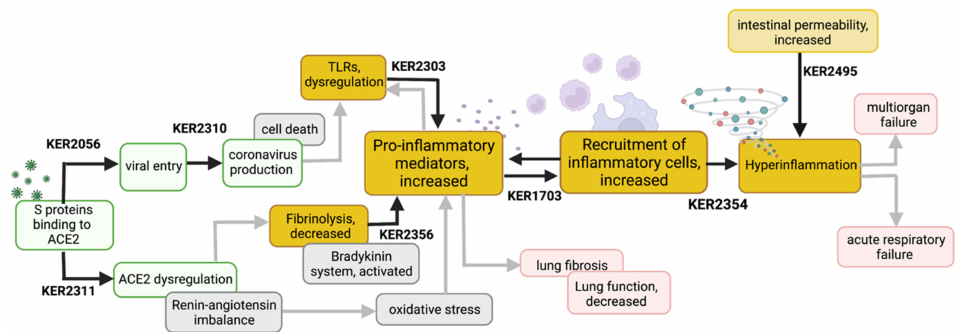
Figure 3. Simplified AOP network depicting COVID-19 pathogenesis, highlighting the biological key steps for evaluation of the mechanisms by which the eleven selected MFs affect the relationships between two KEs, namely the KERs (black arrows). Green boxes: initial events depicting the infectious process and ACE2 dysregulation. Orange boxes: central inflammatory events. Red boxes: AOs. Grey arrows and grey boxes: KERs and KEs identified in COVID-19 but not investigated in detail here. Created with Biorender.com.